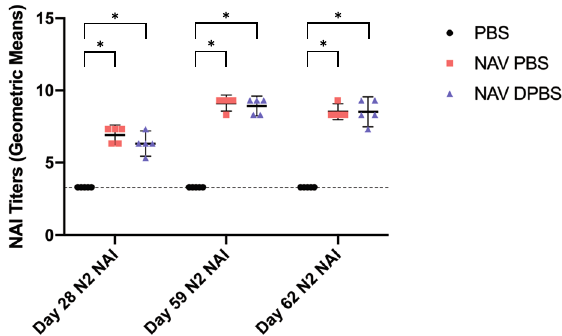
Fig. 6 Immunogenicity of NAV PBS and NAV DPBS as assessed by NAI titers against N2. Mice were vaccinated with NAV in PBS (red squares), NAV in DPBS (blue triangles), and PBS control (black circles) on days 0 and 28 and challenged with 10 5 TCID 50 A/Bethesda/MM2/ 2009 (H1N1) on day 56. Blood was collected on days 28, 59, and 62 for assessment of NAI titers against N2 ( n = 5 mice per condition per time point). Points represent log 2 geometric means of individual mice and error bars represent means and standard deviations. Dotted line represents minimal limit of detection. ANOVA and post- hoc Tukey test were performed where * p < 0.0001.